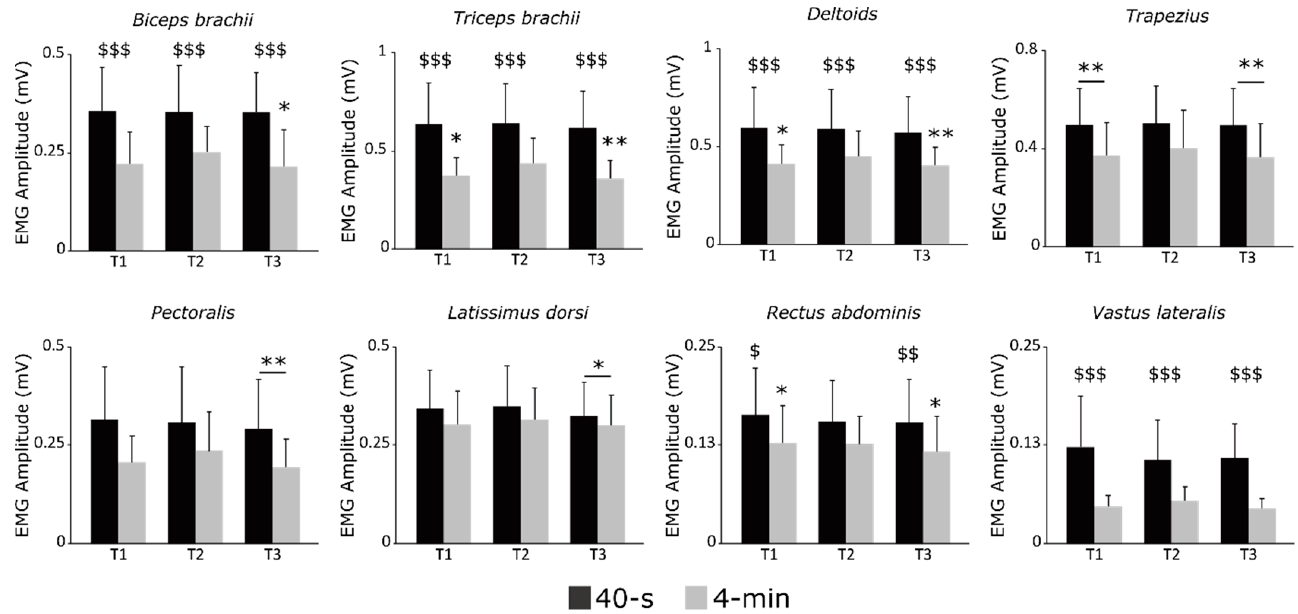
Figure 3. EMG amplitude of muscle activations recorded at the beginning (T1), middle (T2), and end (T3) of each sprint (N = 8; mean ± SD). * denotes a significant difference with T2, and $ difference between condition at the corresponding time point. One item ( p < 0.05), two items ( p < 0.01) and three items ( p < 0.001).